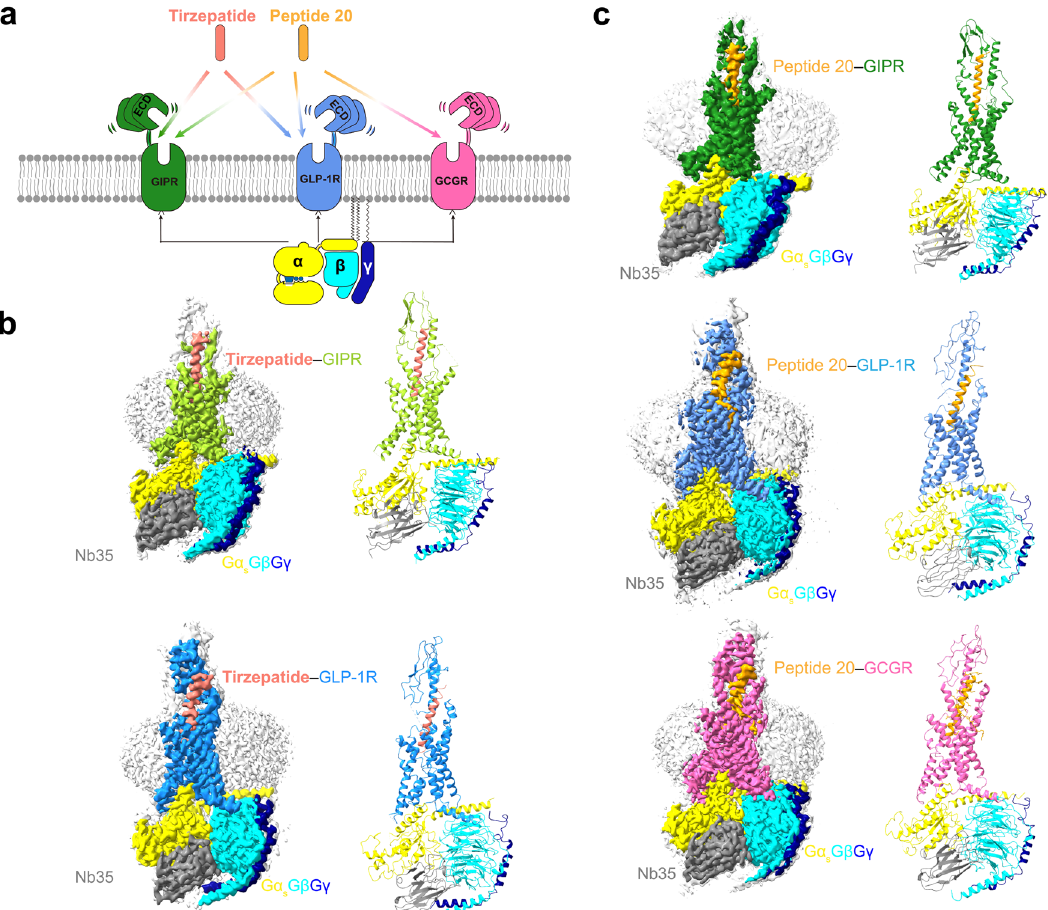
Fig. 1 Cryo-EM structures of tirzepatide and peptide 20-bound GIPR, GLP-1R and GCGR in complex with G s . a Multi-targeting peptides tirzepatide and peptide 20 possess distinct combinatorial agonism at GIPR, GLP-1R and GCGR. b Cryo-EM maps (left) and structural models (right) of tirzepatide-bound GIPR (top) and GLP-1R (bottom) in complex with G s . The sharpened cryo-EM density map at the 0.243 threshold shown as light gray surface indicates a micelle diameter of 10 nm. The colored cryo-EM density map is shown at the 0.424 threshold. The tirzepatide is shown in salmon, GIPR in yellow green, GLP-1R in dodger blue, G α s in yellow, G β subunit in cyan, G γ subunit in navy blue and Nb35 in gray. c Cryo-EM maps (left) and structural models (right) of peptide 20-bound GIPR (top), GLP-1R (middle) and GCGR (bottom) in complex with G s . The sharpened cryo-EM density map at the 0.228 threshold shown as light gray surface indicates a micelle diameter of 11 nm. The colored cryo-EM density map is shown at the 0.576 threshold. The peptide 20 is shown in orange, GIPR in forest green, GLP-1R in blue, GCGR in hot pink, G α s in yellow, G β subunit in cyan, G γ subunit in navy blue and Nb35 in